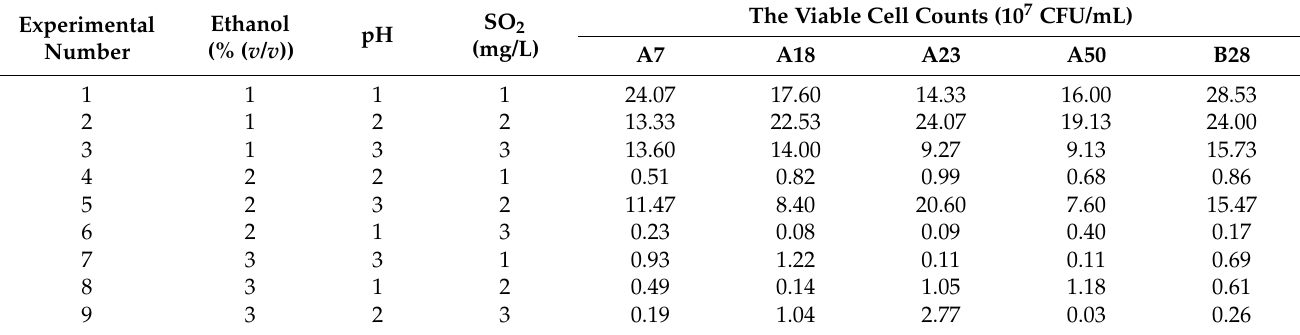
Figure 6. The average value of twenty L. plantarum and control strains under nine groups combination of stresses. Different small letters indicate significant differences according to the LSD Fisher test ( p < 0.05). Table 3. The viable cell counts of orthogonal